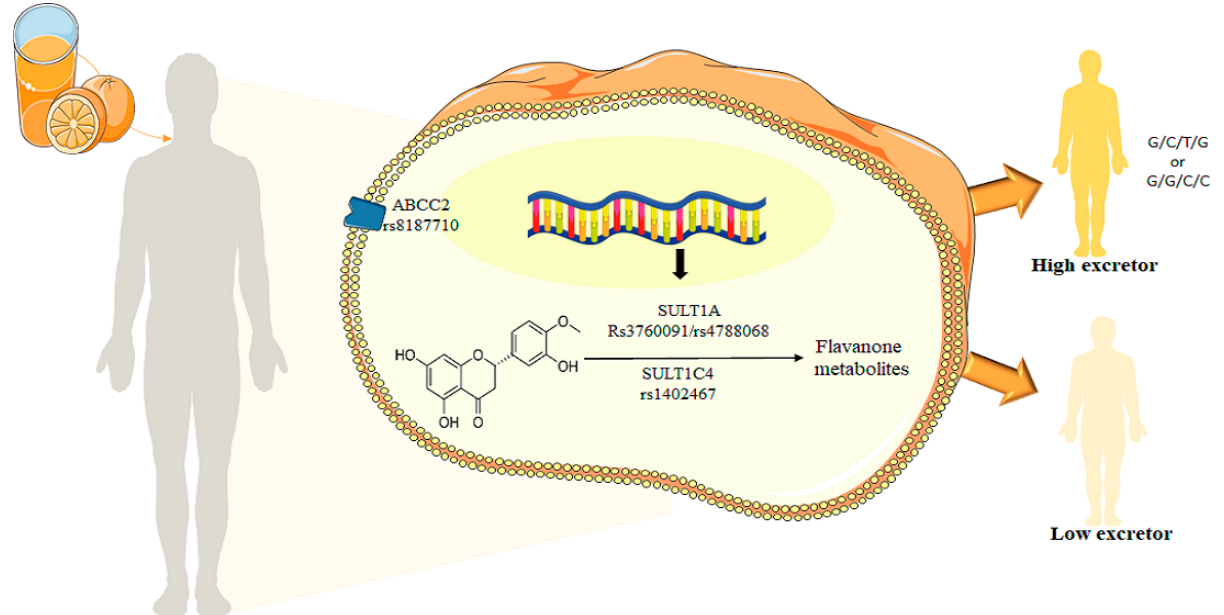
Figure 5. Total metabolite concentrations in urine depending the GGCC and GCTG haplotypes for ABCC2_rs8187710/SULT1A1_rs3760091/SULT1A1_rs4788068/SULT1C4_rs1402467 with phenotype high excretors.